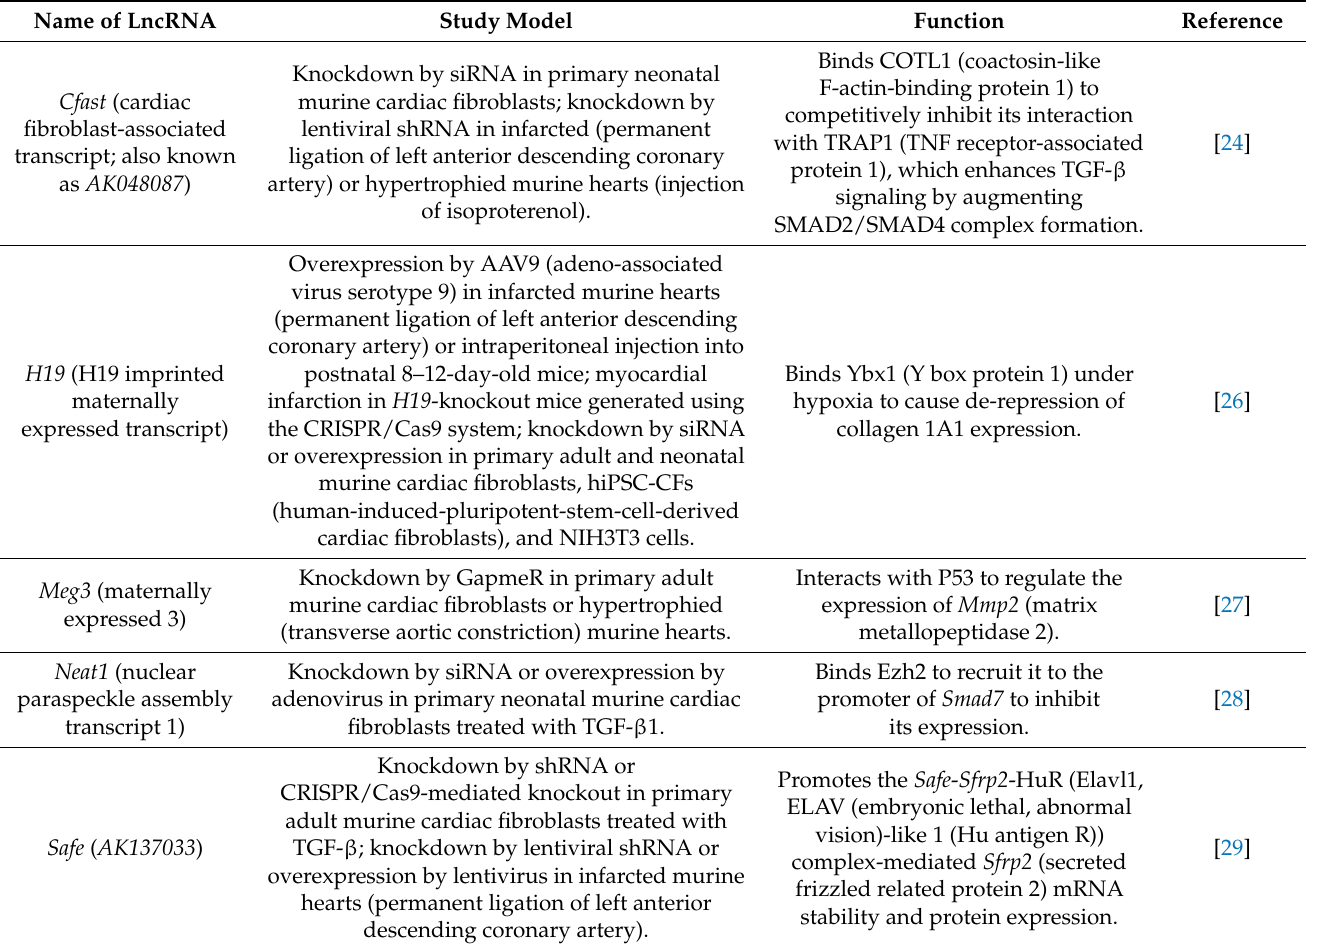
Table 1. List of functionally and mechanistically characterized cardiac fibrotic